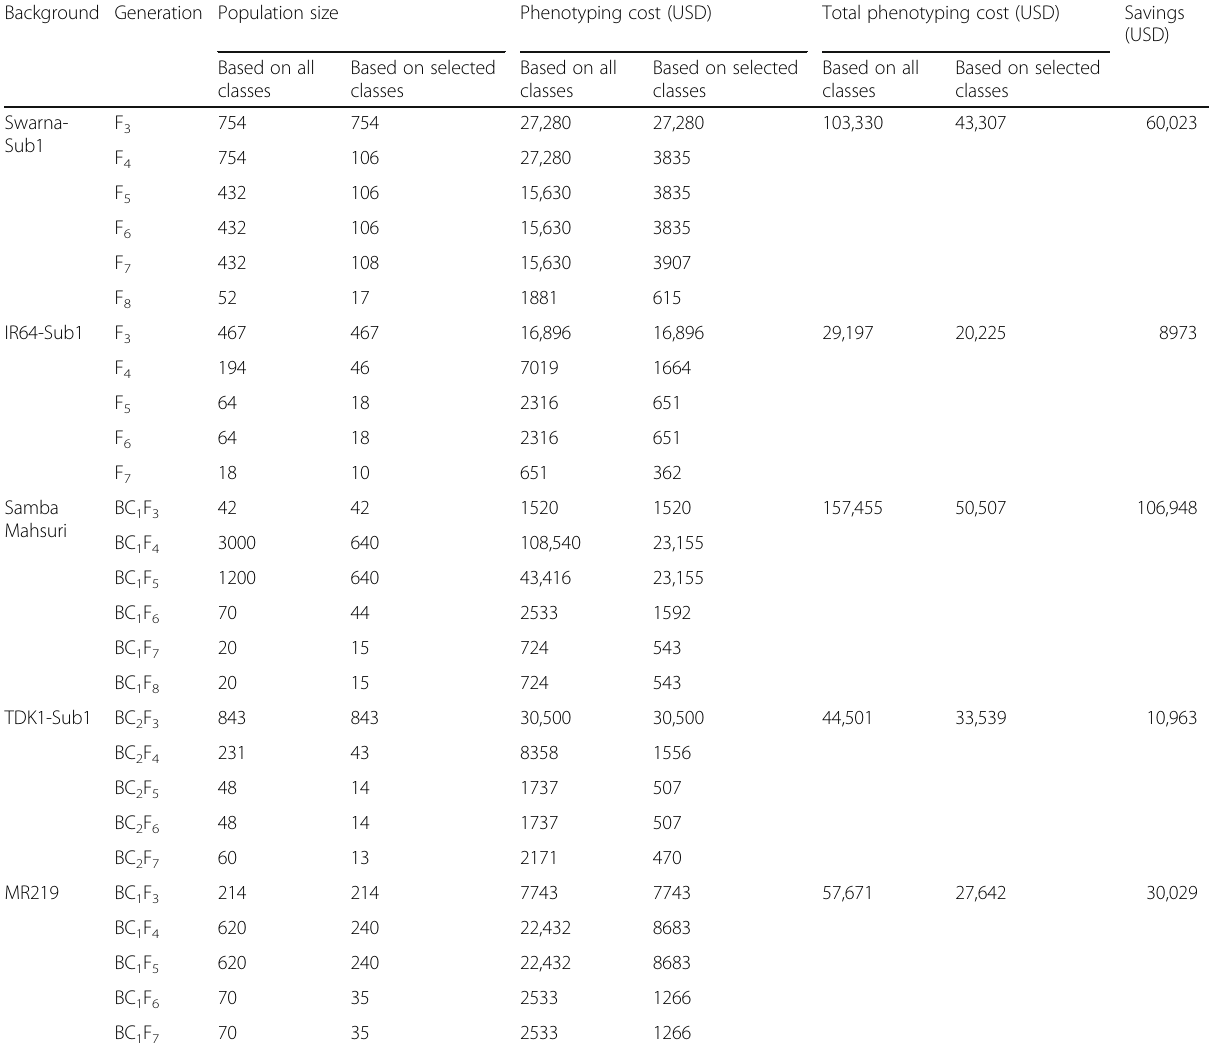
Table 7 Comparison of phenotyping cost (USD) considering advancement of all QTL classes versus advancement of only higher performing F 3 generation QTL